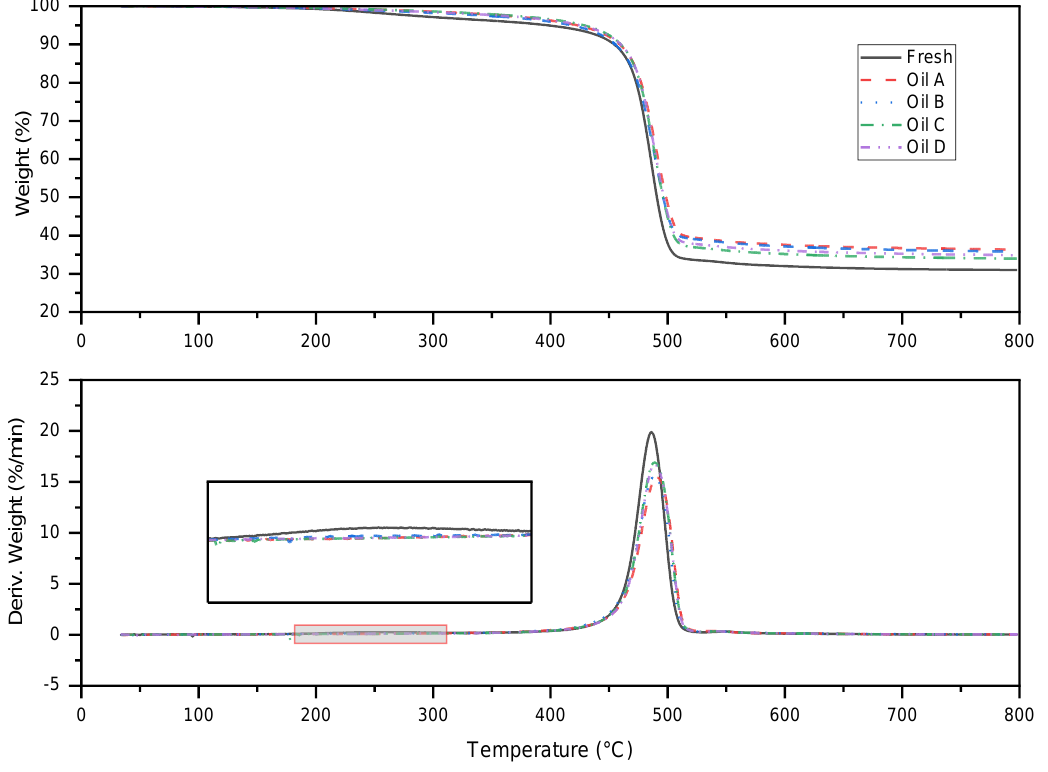
Figure 11. TGA (above) and DTGA (below) curves expressed as mass percentage and mass percentage over time, for fresh and 168 h aged FKM. Table 7. TGA and DTGA data of fresh and 168 h aged FKM.